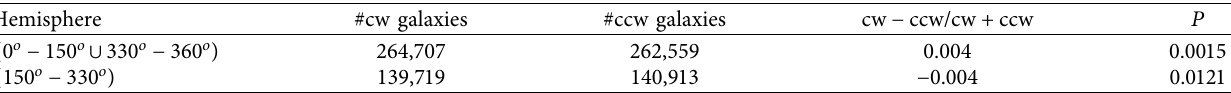
Table 4: Te number of galaxies spinning clockwise and galaxies spinning counterclockwise in opposite hemispheres. Te table is taken from [6].